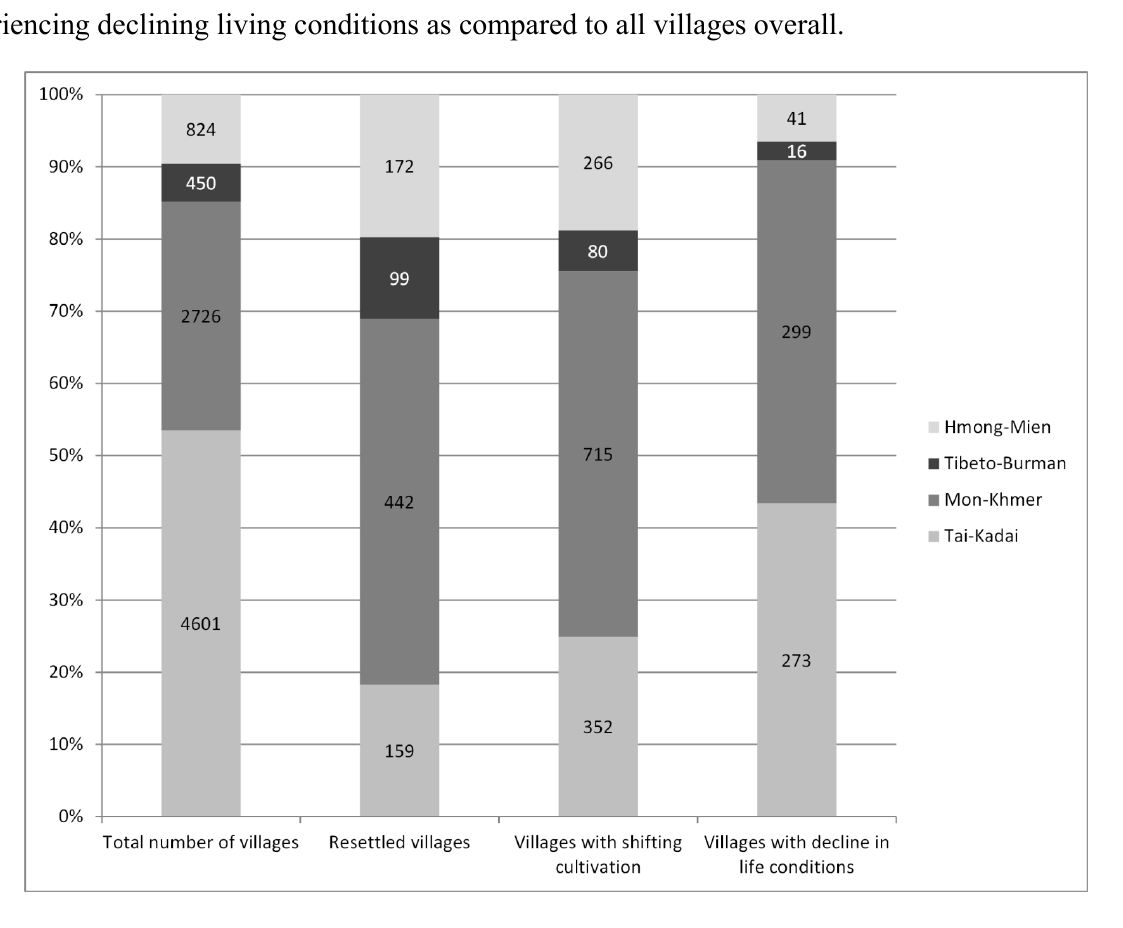
Figure 3. Distribution of resettled villages and their characteristics in relation with aggregated ethnolinguistic